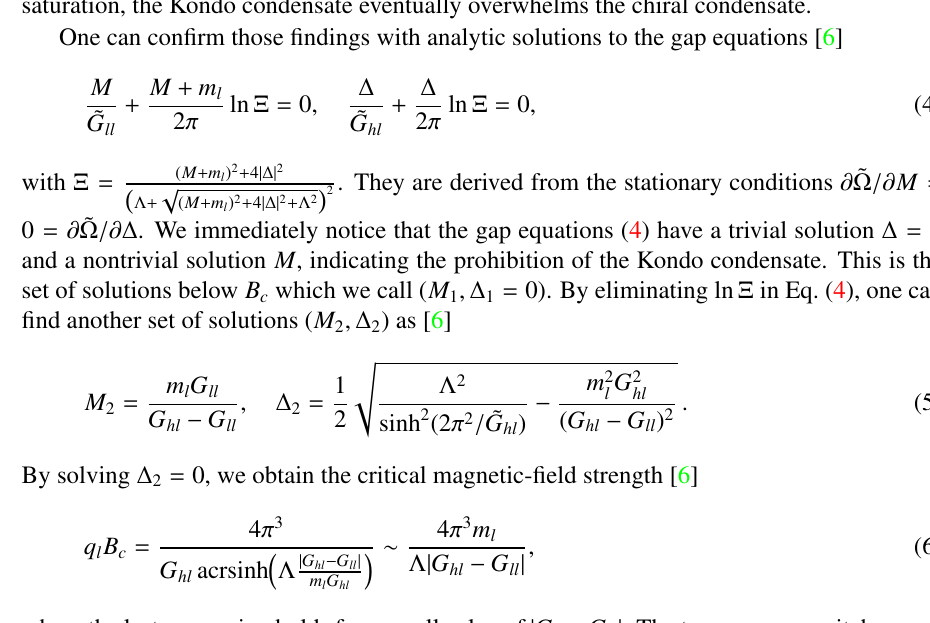
strength to B c , indicating that the Kondo e ff ect is prohibited by the existence of the chiral condensate in the regime between B cK and B c . However, once the Kondo condensate appears at B c , the chiral condensate, shown with the red line, saturates at a constant value. Such a saturation of the chiral condensate serves as a clear signal of the emergence of the Kondo condensate since it has been known that the chiral condensate monotonically increases by the magnetic catalysis [1] if the heavy-quark impurity is absent or formally G hl = 0. Due to this saturation, the Kondo condensate eventually overwhelms the chiral